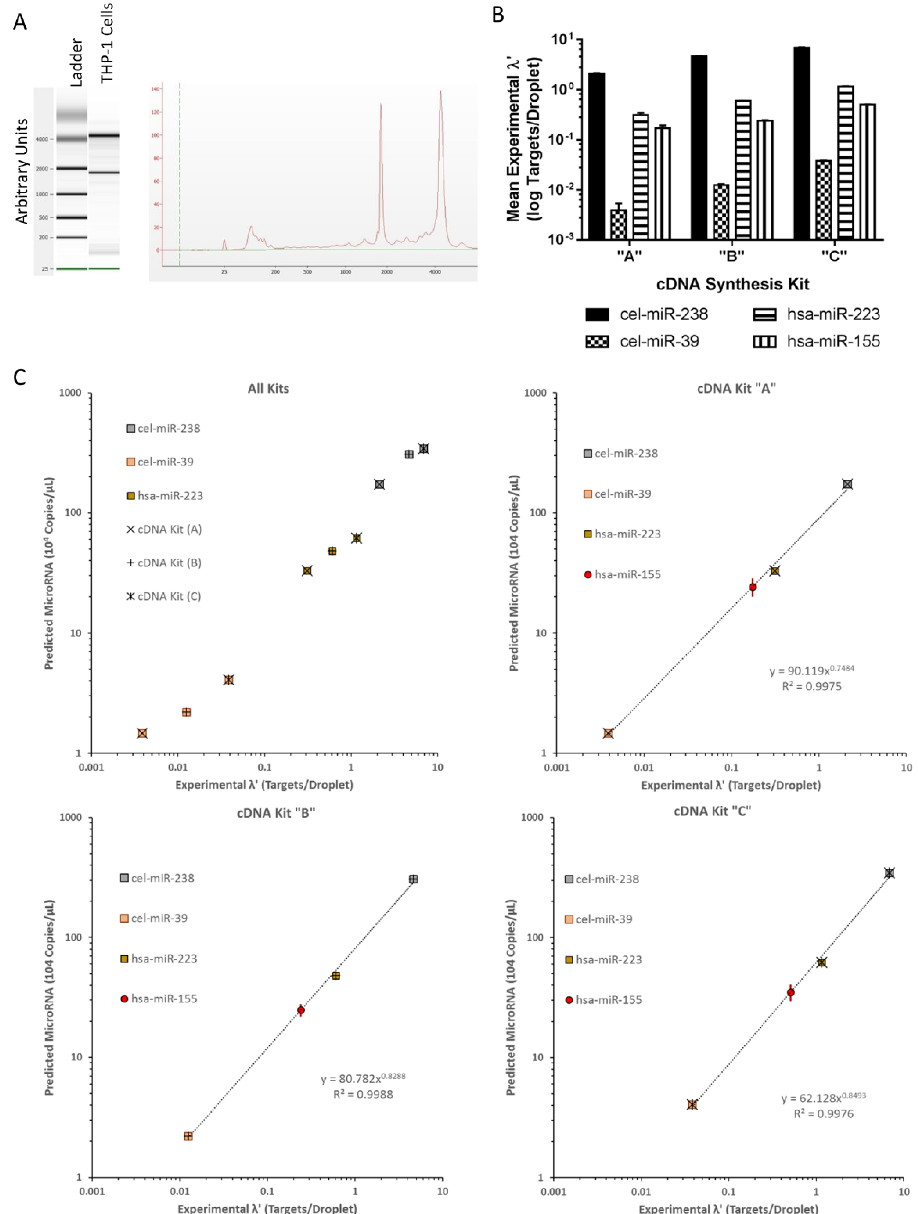
Fig 7. Quantitative miRNA measurements in THP-1 cells. Total RNA was extracted from macrophage derived THP-1 cells and was (A) analyzedfor integrity, purity, and concentration using the chip-based automatedelectrophoresis system. (B) Total RNA was reverse transcribedby cDNA synthesis kit “A”, “B”, or “C” and specific miRNA targets were measuredusing ddPCR. (C) Each kit, “A” ( × ), “B” (+), and”C” ( ӿ ), was used to make cDNA and total number of targets were countedvia ddPCR. Average NTC and NEC were similarlymeasuredfor each experiment. For all targets, cel-miR-238 (gray), cel-miR-39(orange),hsa-miR- 223 (brown), and hsa-miR-155 (red), fraction positive targets per droplet were calculatedby subtractingNEC and NTC positive and applyingPoissondistribution.Predicted 10 4 miRNA copies/ μ Lfor cel-miR-238 (gray square),cel-miR-39(orange square), and hsa-miR-223 (brown square) was calculatedusing pre-existing power curve values (Table 6). For each respectivekit, a new power curve was developed using experimental versus predicted cel-mir-238,cel-miR-39, and hsa-miR-223 concentration (Table 7). This new power curve was appliedto respective, endogenouslymeasured, experimental hsa-miR-155 λ ’ to generatepredicted hsa- miR-155(red circle) copies/ μ L.The standard uncertainty is shown on the graph for hsa-miR-155 for each respectivepoint (dark red line). For visualization purposes, data is either graphedon one chart or separated out basedon cDNA synthesis kit. New power models are calculatedonly for individual cDNA synthesis